Question: Identify the chart type used in this figure.
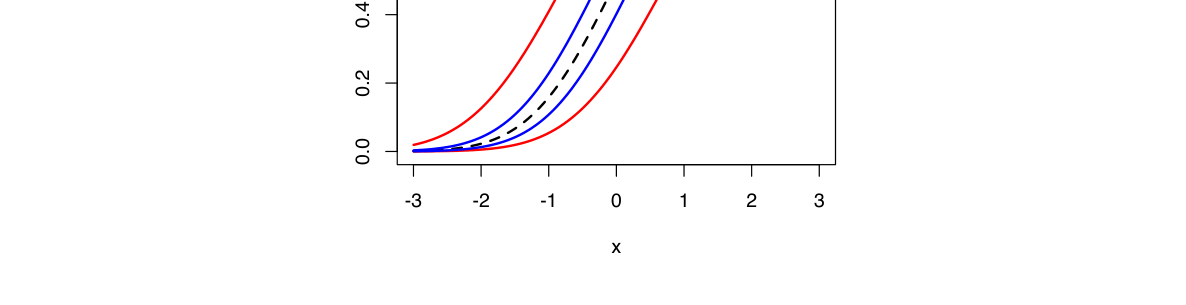
Answer: line